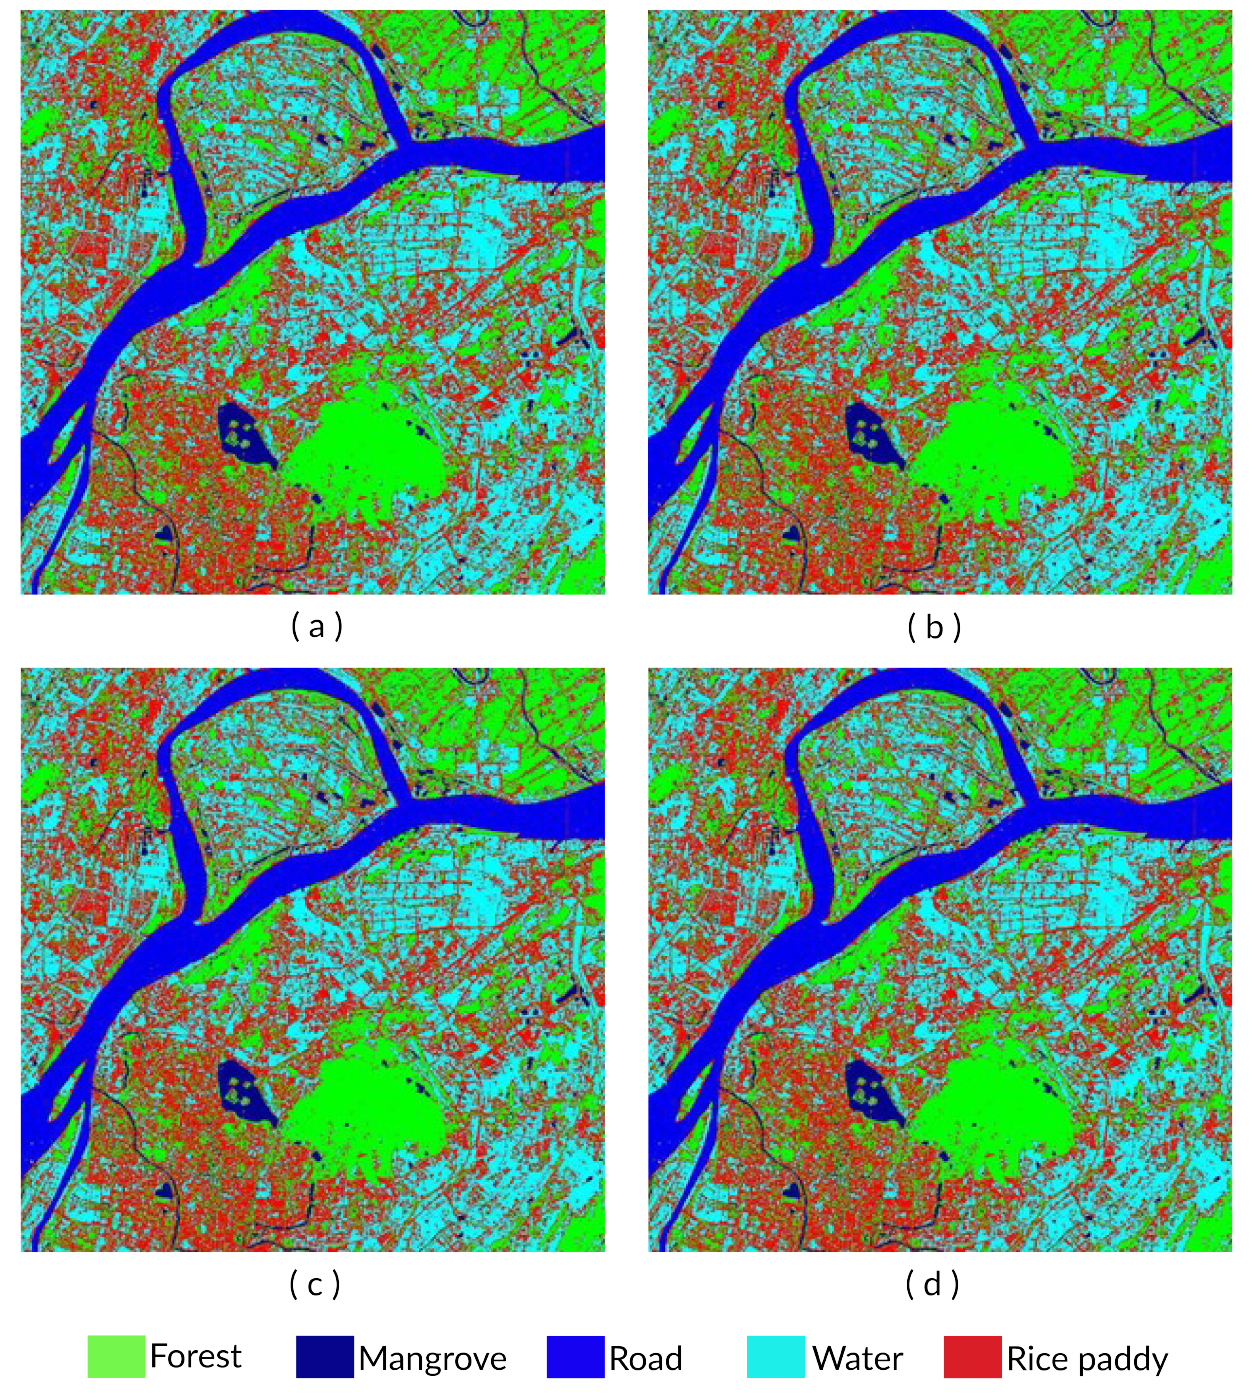
Figure 12. Four images representing the classification results with four classifiers. ( a ) Classification result with the MDC; ( b ) Classification result with the MLC; ( c ) Classification result with the SVM using a linear kernel; ( d ) Classification result with the SVM using a default